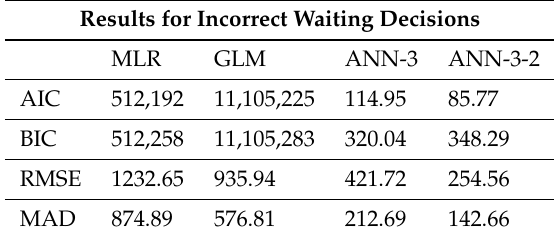
Table 4. Comparison of goodness of fit of MLR, GLM, ANN models with one hidden layer and with two hidden layers to the numbers of IWDs at the simulation end, measured by AIC, BIC, RMSE,